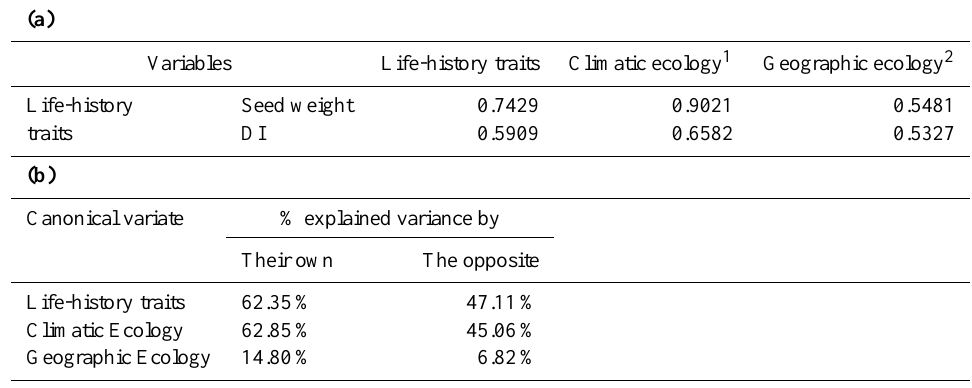
Table 1. Canonical correlation analysis between individual variables and their own and opposite set of